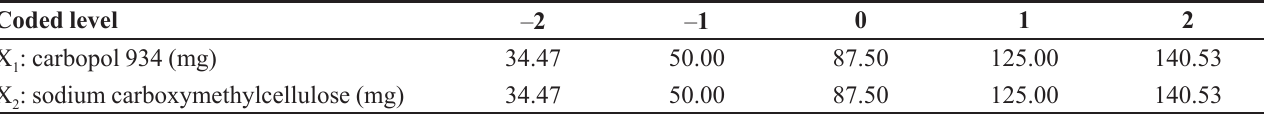
TABLE II - Detail of coded levels in actual units for the selected variables at five levels Coded